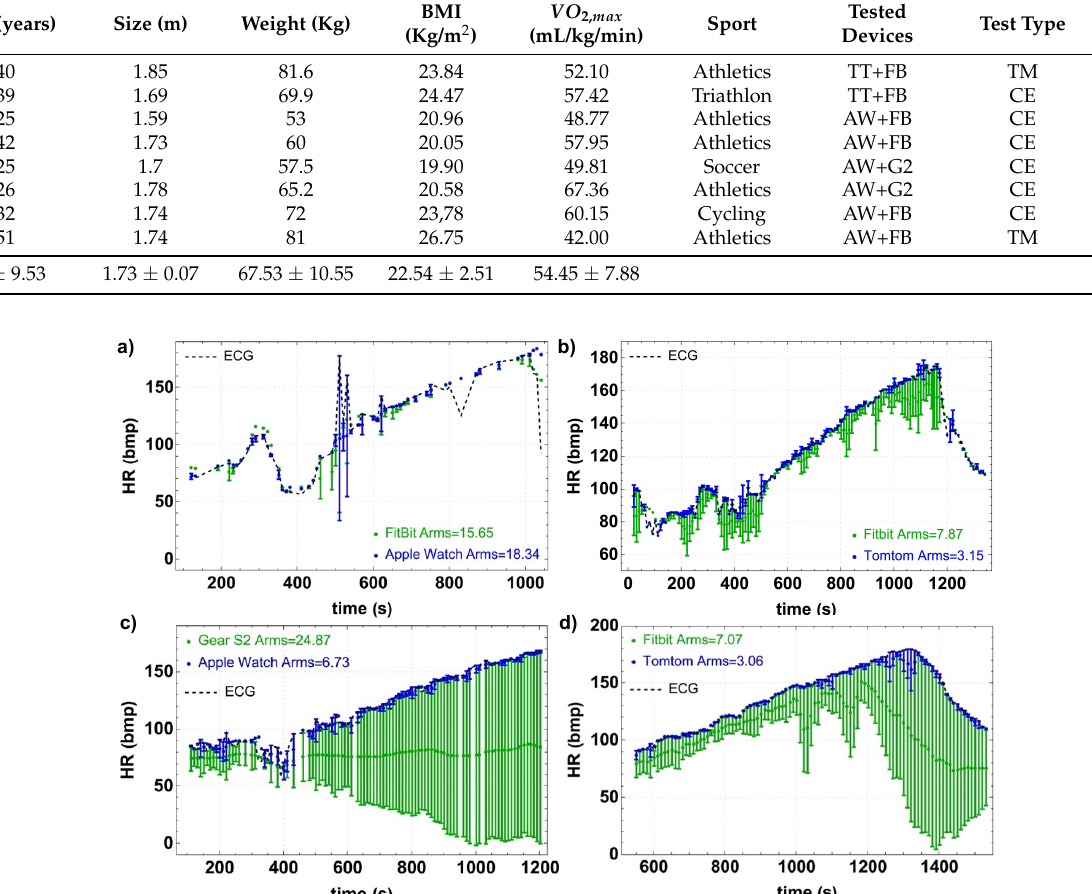
Figure 2. Wristband measurements for four athletes compared to the reference ECG data in the two different tests: treadmill (top panels, ( a , b )) and cycle ergometer (bottom panels, ( c , d )). The black line corresponds to the ECG data, while the blue and green lines correspond to the tested devices. The error bars denote differences between the ECG data and the tested